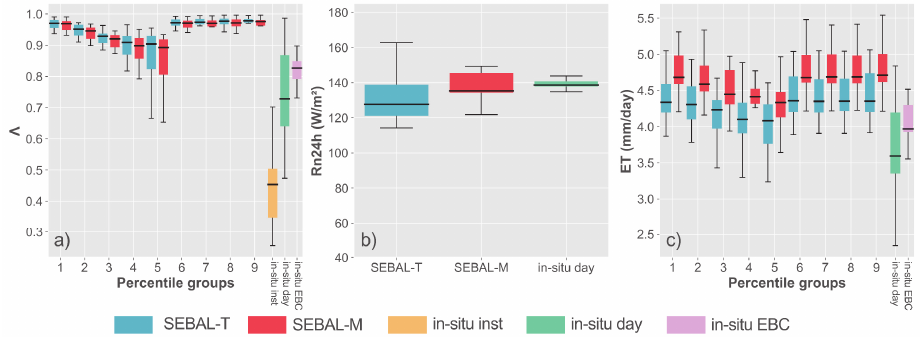
Figure 5. Comparison between ground measurements (where in situ inst and day stand for instantaneous and daily measurements without energy balance closure, respectively, and in situ EBC measurements with energy balance closure) and SEBAL estimates of evaporative fraction ( Λ ) ( a ), daily net radiation ( R n ) ( b ), and daily evapotranspiration ( ET 24 h ) ( c ) driven by in situ meteorological measurements (SEBAL-T) and MERRA-2 (SEBAL-M).